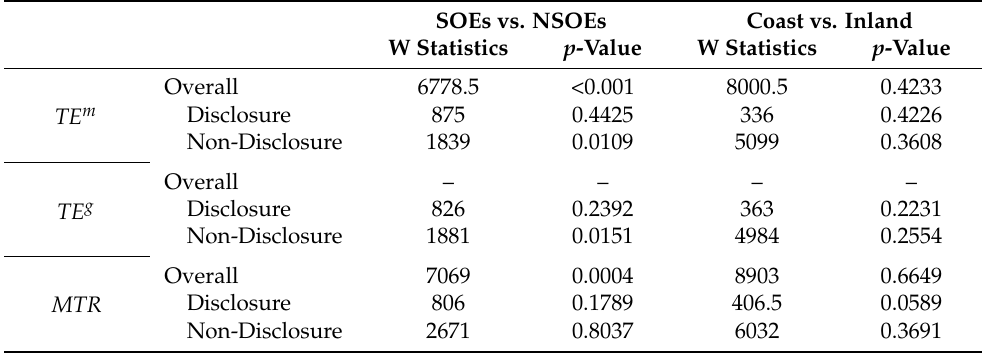
Table 6. Wilcoxon Rank Sum Tests of Different Owner Types and/or